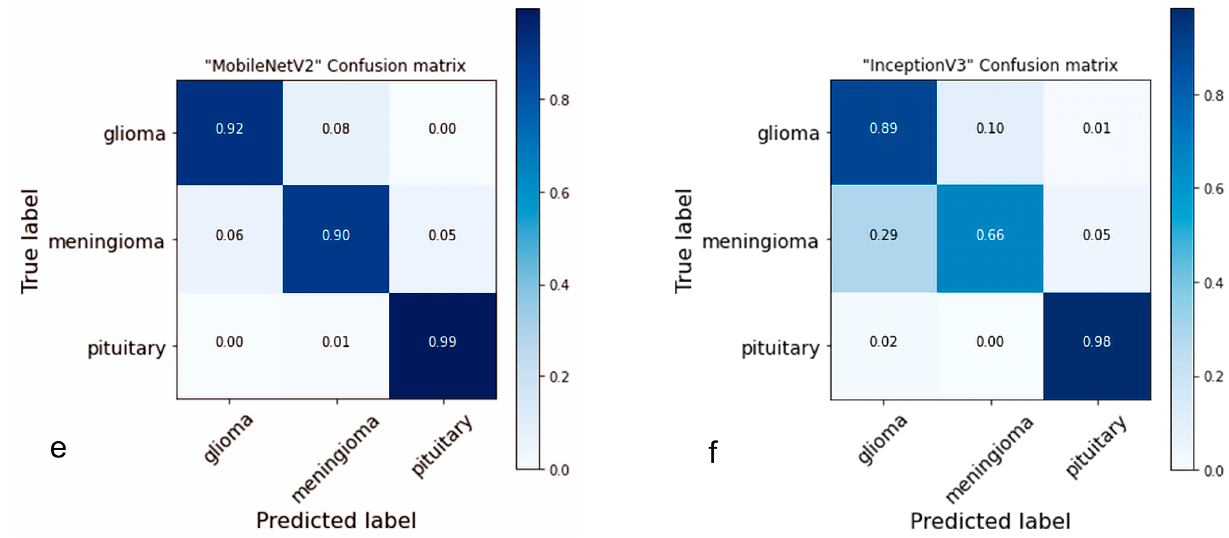
Figure 7. The confusion matrices of the proposed and pre-trained models on the testing data are presented in Figure 7. The figure displays the prediction rate of each model. Specifically, ( a ) illustrates that the proposed model achieved a high accuracy rate of 98.04%. Comparatively, ( b ) shows that VGG16 obtained an accuracy rate of 90.70%, ( c ) reveals that VGG19 achieved 92.82%, ( d ) demonstrates that the accuracy rate of ResNet50 was 94.77%, ( e ) indicates that MobileNetV2 achieved 93.47%, and lastly, ( f ) depicts that InceptionV3 achieved an accuracy rate of 85.97%.